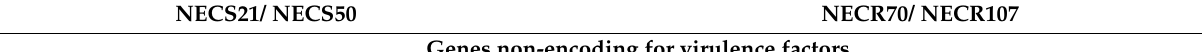
Table 5. Comparison between wild-type and target strains based on Stop gain affected